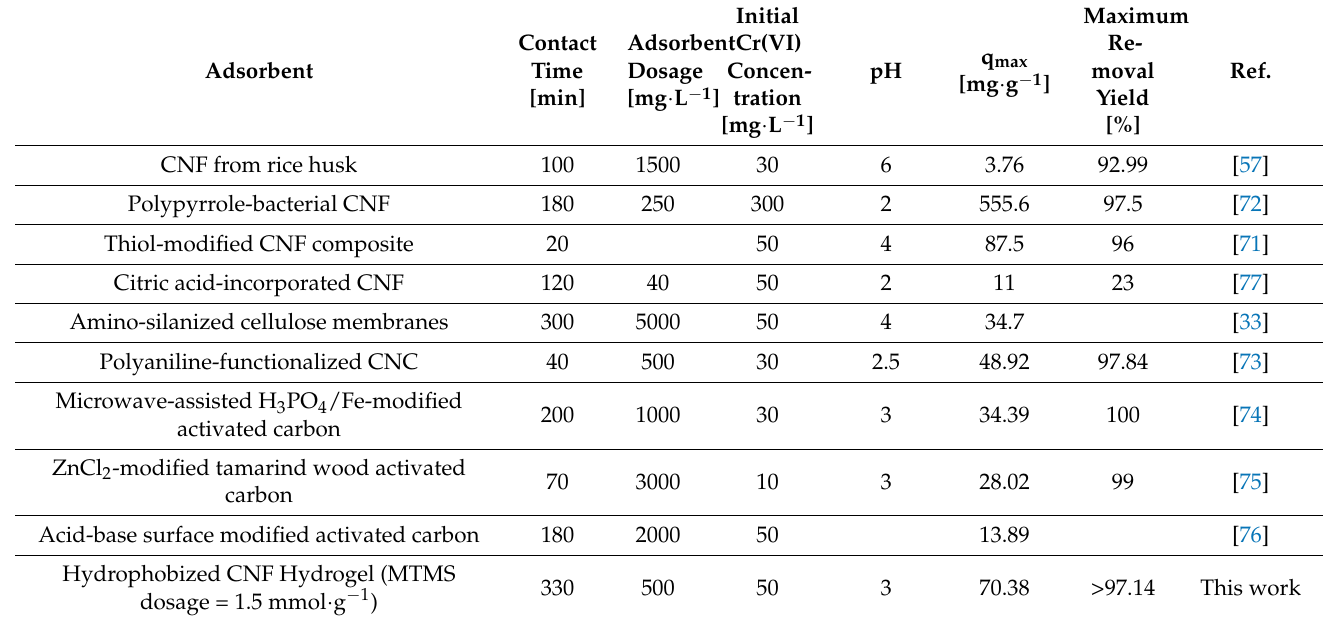
Table 3. A comparison of the hexavalent chromium adsorption through different NC and activated carbon